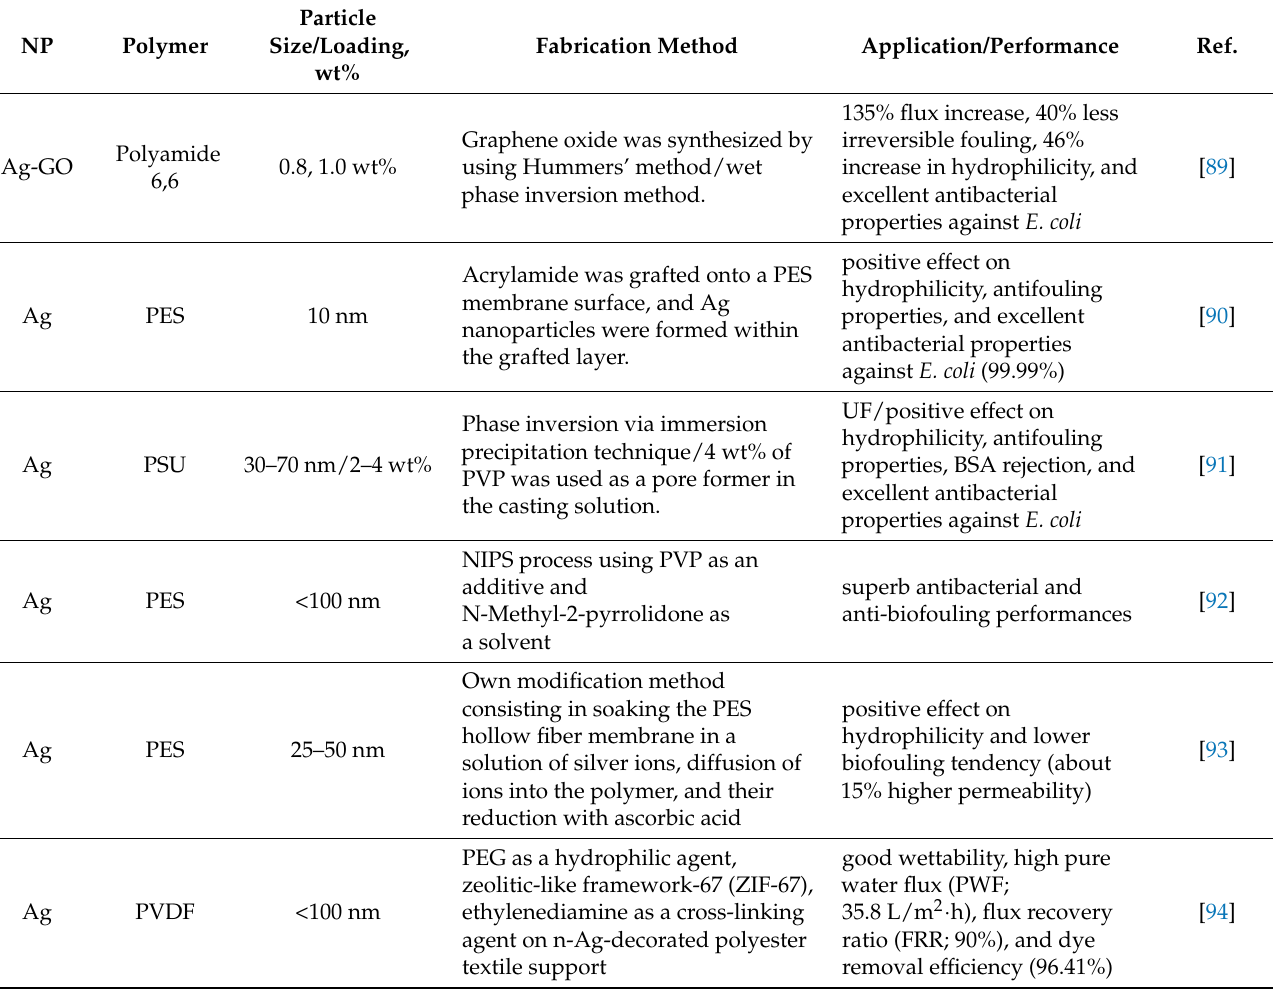
Table 2. Selected applications of various types of silver in